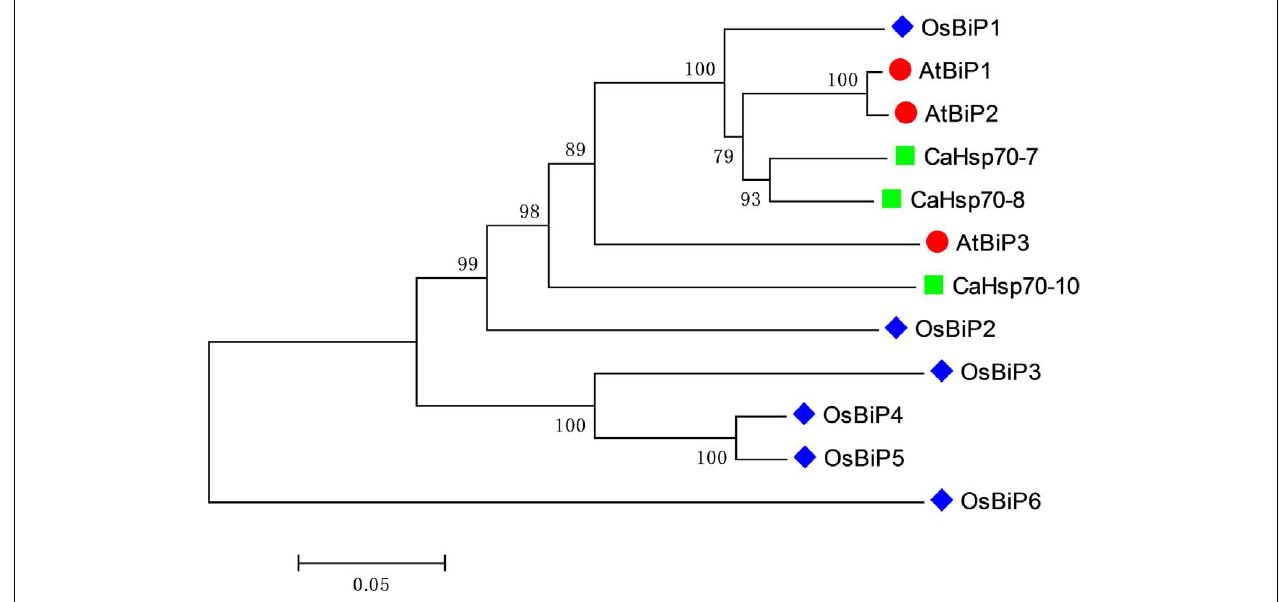
FIGURE 1 | Phylogenetic tree of BiP family members from representative plant species. Ca, Capsicum annuum L. ; At, Arabidopsis thaliana ; Os, Oryza sativa